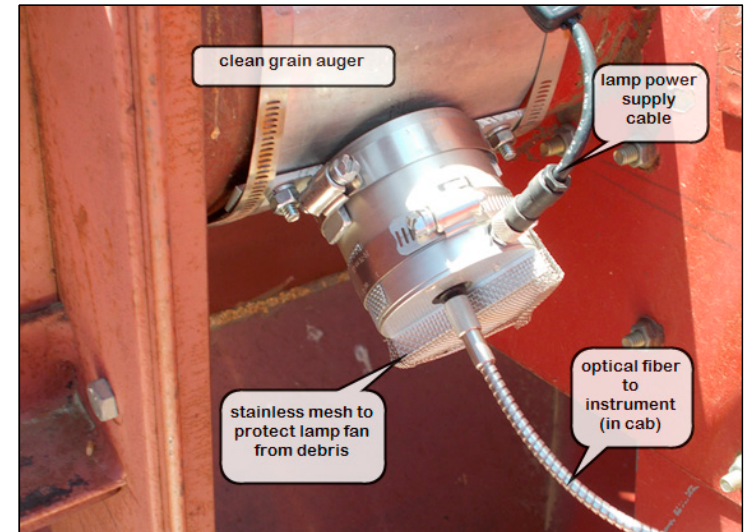
Figure 1. Sensor head and fiber optic cable of the Avaspec model 2048 spectrometer mounted to the combine’s grain bin filling auger to measure grain protein and detect green plant material in the harvested grain.